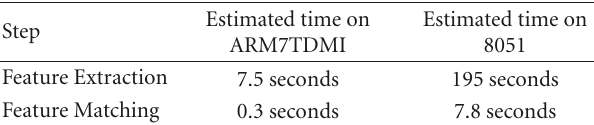
Table 2: Number of instructions and estimated time for fingerprint